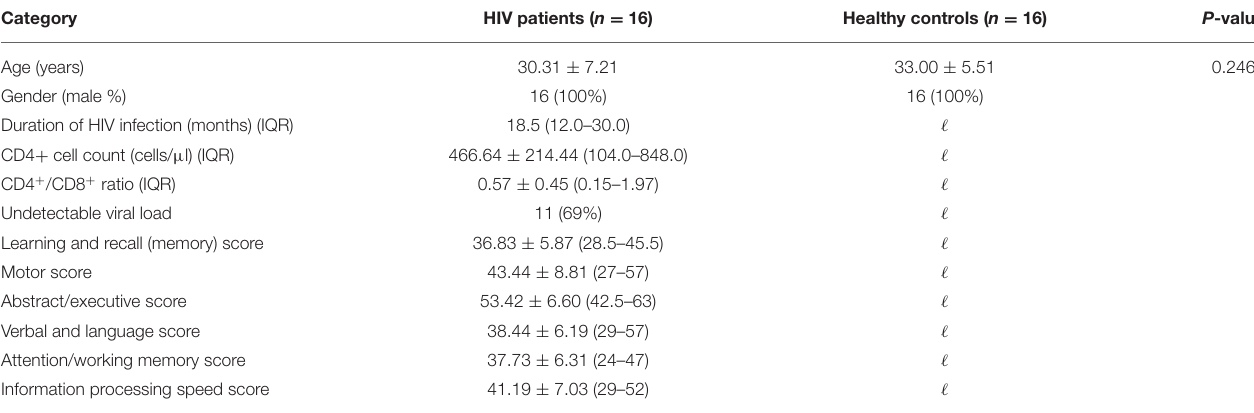
TABLE 1 | Demographic and clinical assessments of HIV patients and healthy controls.